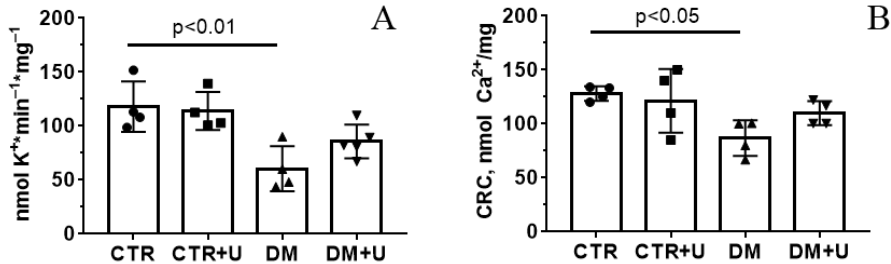
Figure 6. Assessment of the transport of potassium and calcium ions in the heart mitochondria of mice in the experimental groups. The rate of DNP-induced release of K + from the heart mitochondria of experimental animals ( A ). Ca 2+ retention capacity of the heart mitochondria of the experimental animals ( B ). The experimental conditions are described in the Section 4. All data are presented as means ± SD ( n =